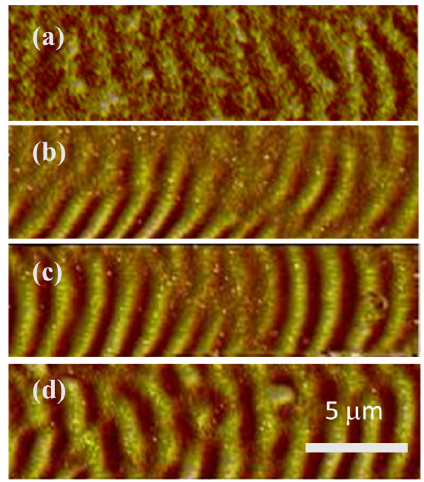
Figure 5. Magnetic domain structures of the as-cast (Co-Fe)-based microwires: ( a ) as-cast state; ( b ) 200 mA AJA; ( c ) 250mA AJA; ( d ) 550mA AJA; Horizontal direction is the axial direction of the